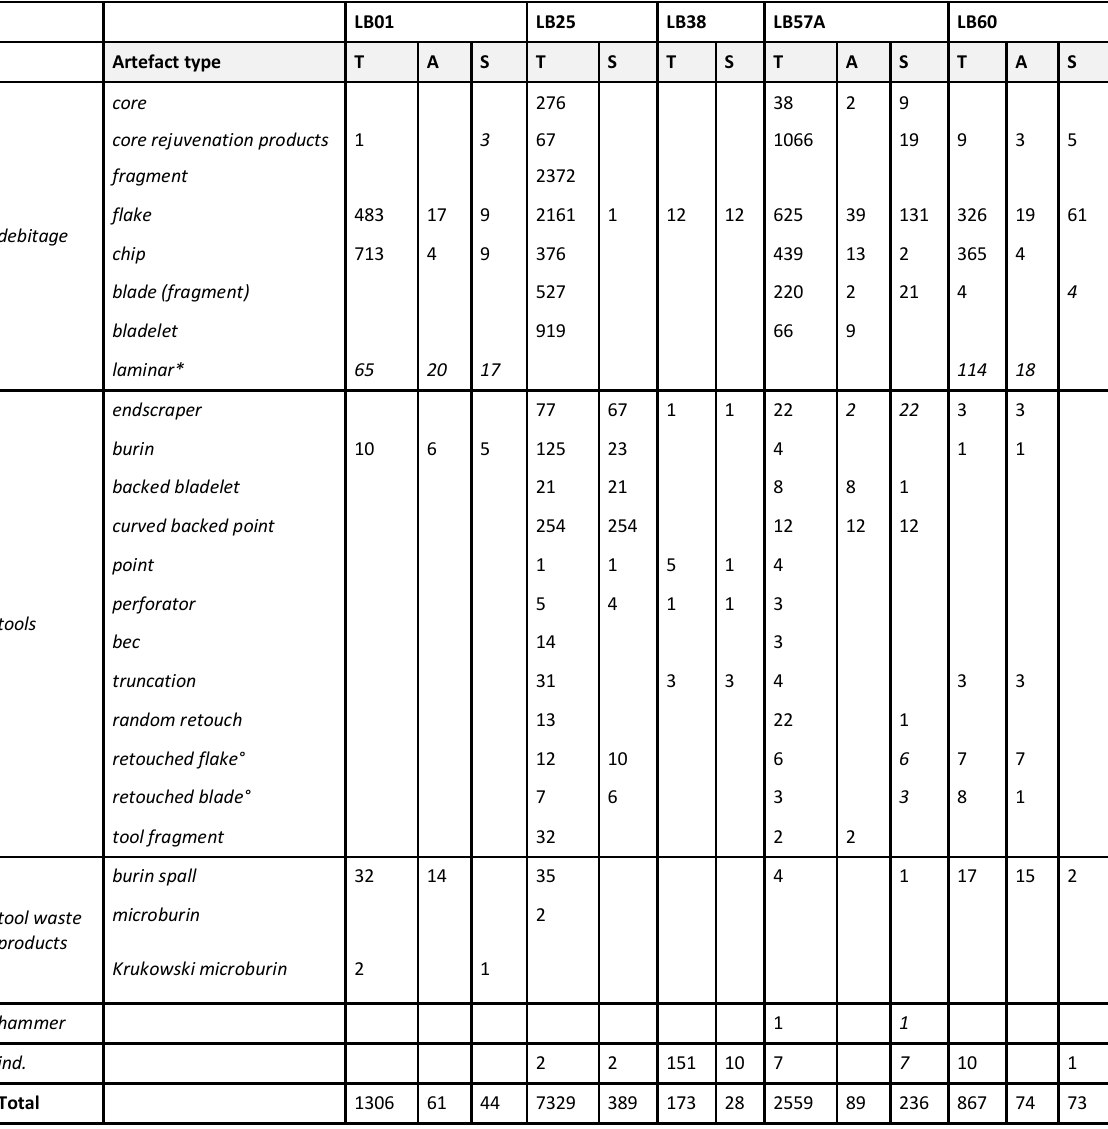
Table 2 . Overview of the total number of lithics (T), lithics selected by the archaeologist (A), number of lithics screened for functional evidence